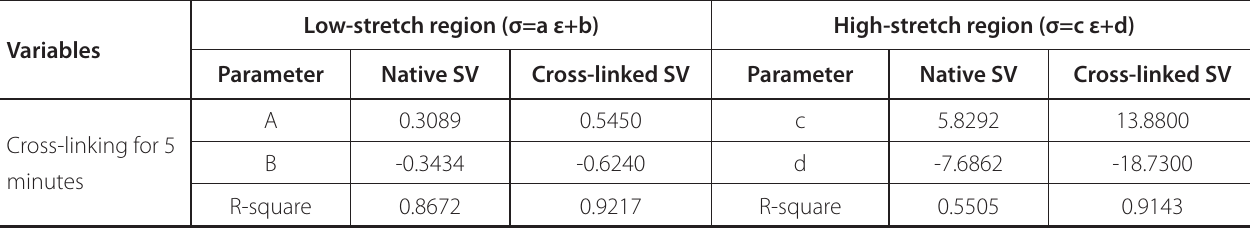
Table 1 . The mechanical constants of saphenous veins (SVs) with or without cross-linking. Variables